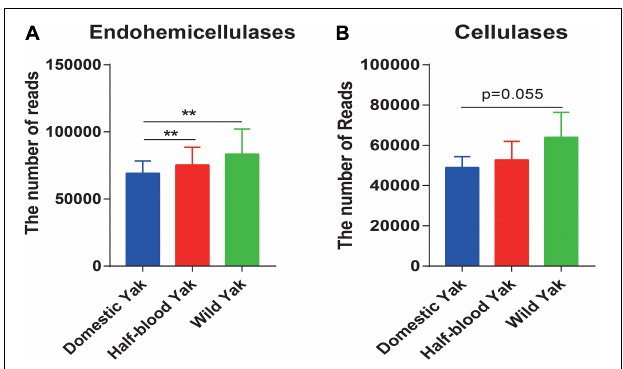
FIGURE 4 | (A,B) The total read number of the GH families encoding hemicellulases and cellulases across the three types of yaks, asterisks indicate significance level between groups ( p > 0.05, no significance; p < 0.05, *; p < 0.01, **; p < 0.001, ***).